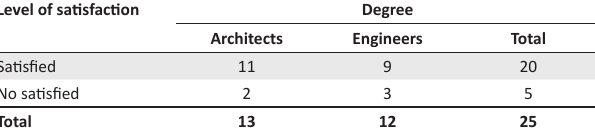
TABLE 5: Level of satisfaction with